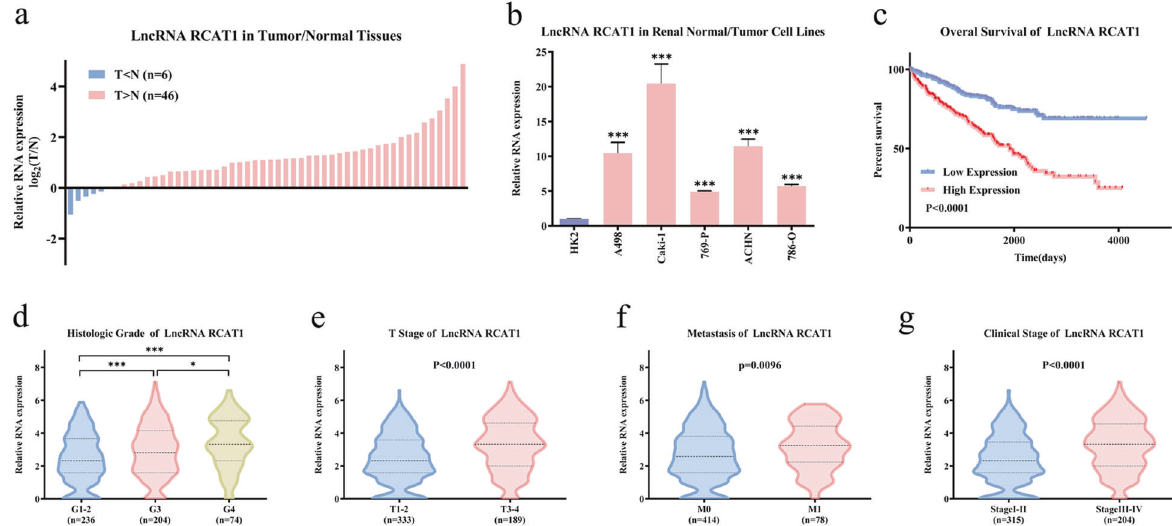
Fig. 3 High lncRNA RCAT1 expression predicts worse prognosis of patients with ccRCC. a The differential expression of lncRNA RCAT1 in ccRCC tissues and normal tissues. b The differential expression of lncRNA RCAT1 in ccRCC cells and normal cells. c The Kaplan – Meier analysis was used to evaluate the relationship between lncRNA RCAT1 expression and overall survival time of ccRCC patients. d – g The differential expression of lncRNA RCAT1 in indicated ccRCC tissues according to TCGA database ( * P < 0.05, *** P <